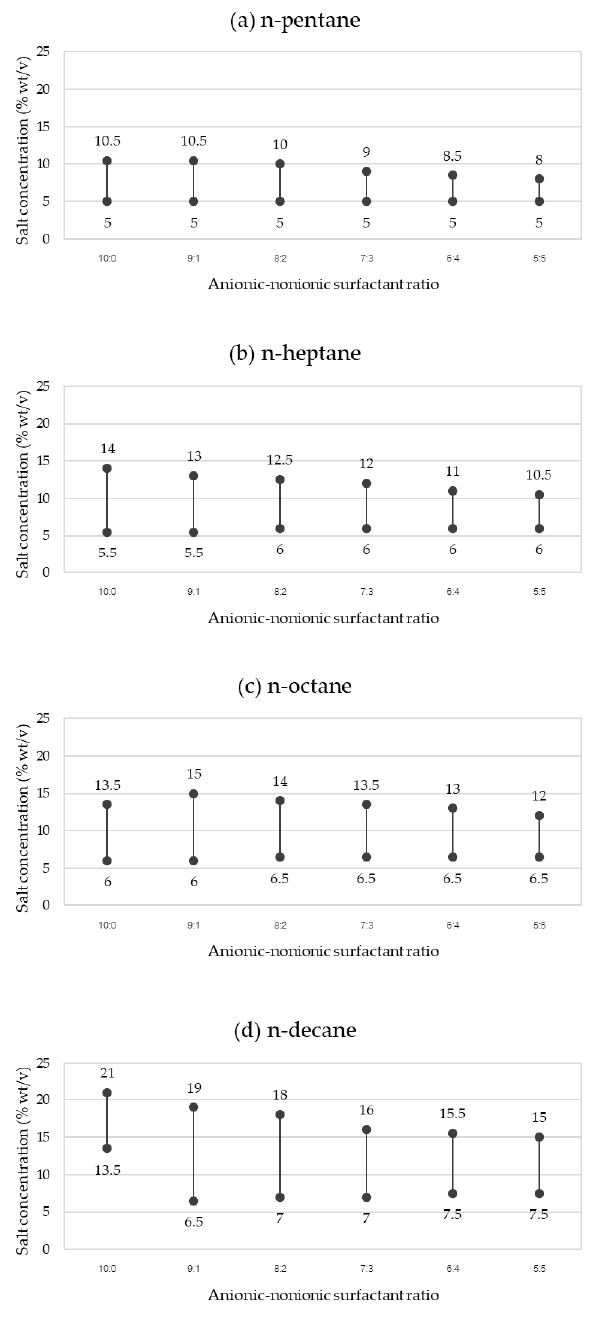
Figure 3. Phase transitions of SDHS-AAE(6EO4PO) systems with ( a ) n-pentane, ( b ) n-heptane, ( c ) n-octane, and ( d ) n-decane.